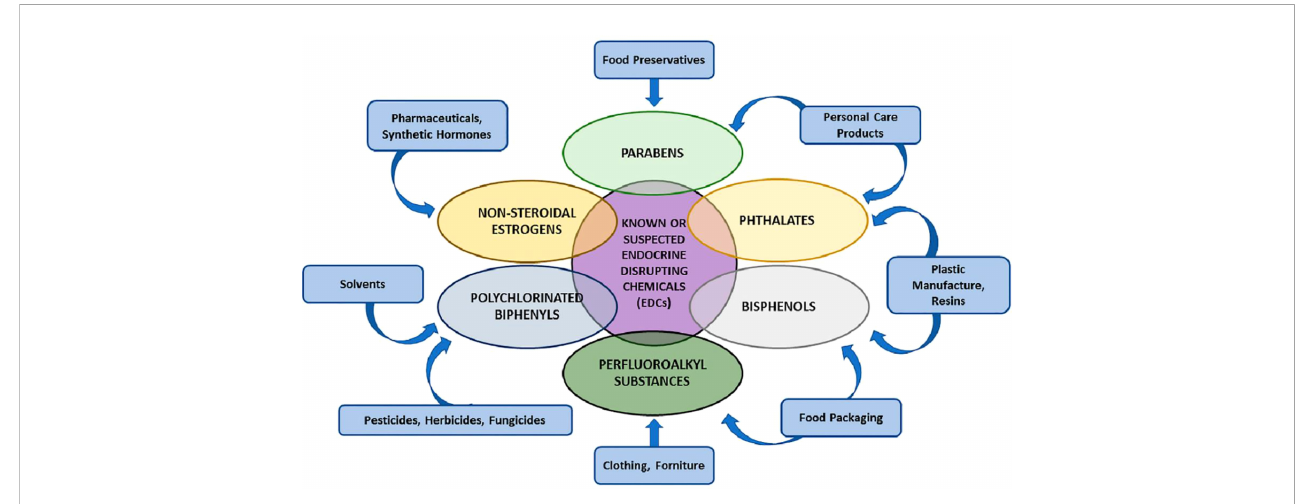
FIGURE 2 Various groups of endocrine-disrupting chemicals (EDCs)